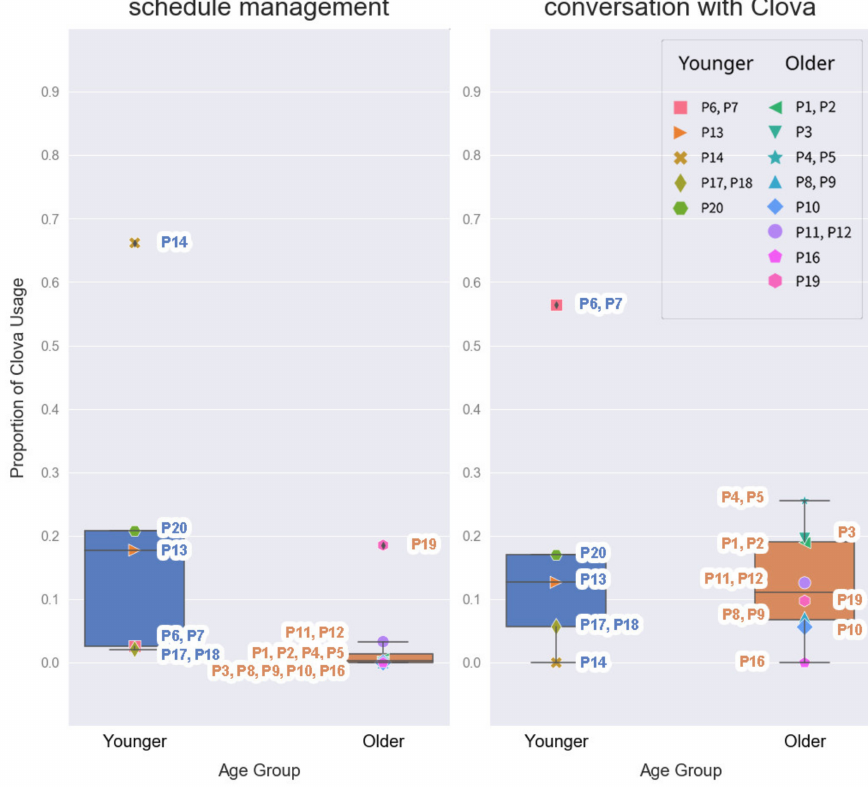
Figure 4. Proportion of Clova usage by age group: schedule management and conversation with